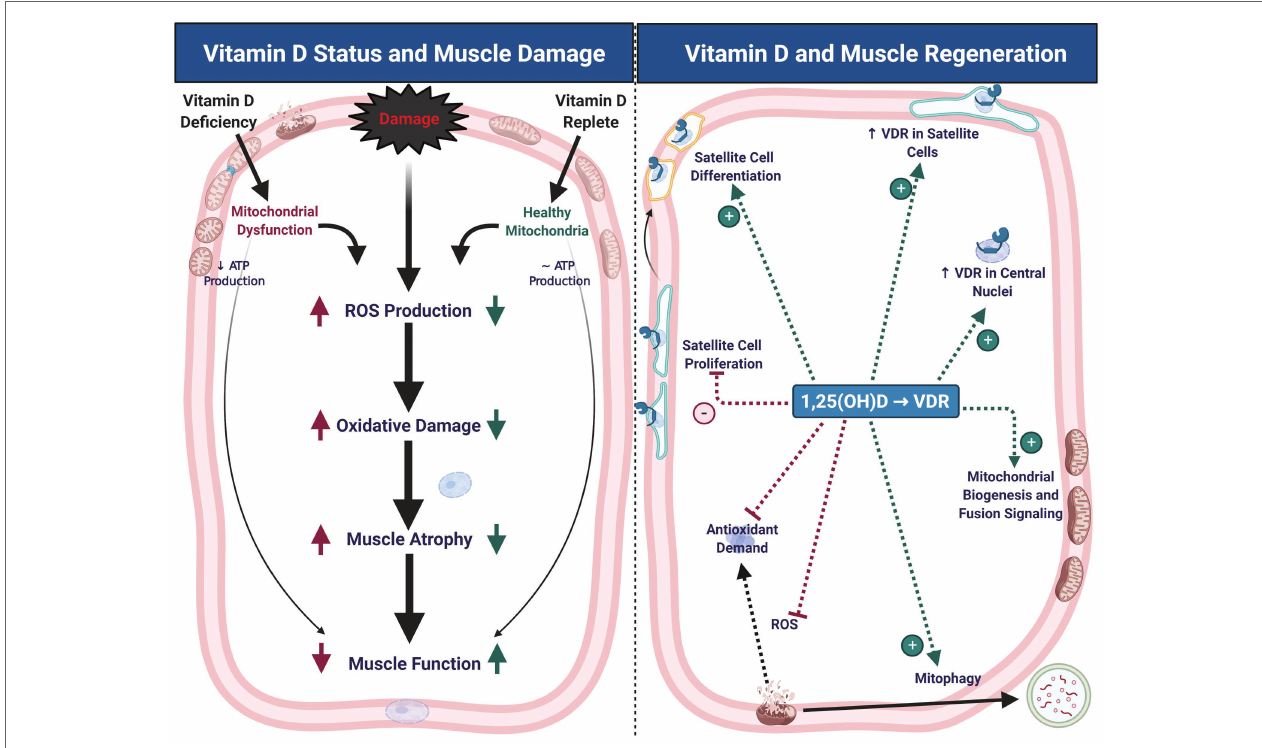
FIGURE 1 | Vitamin D status contributes to muscle damage and regeneration. Vitamin D deficiency leads to mitochondrial dysfunction, decreased adenosine triphosphate (ATP) production, increased reactive oxygen species (ROS) production, oxidative damage, muscle atrophy, and impaired muscle function. These symptoms of deficiency may exacerbate similar symptoms that typically occur with muscle damage (left panel) . During muscle regeneration (right panel) , hydroxylated, activated vitamin D [1,25(OH)D] stimulates an increase in vitamin D receptor (VDR) abundance in satellite cells and central myonuclei. These changes in VDR abundance are accompanied by inhibition of satellite cell proliferation and stimulation of differentiation, which may contribute to maintenance of satellite cell self-renewal capacity. Signaling at the VDR also increases mitochondrial biogenesis and fusion signaling, inhibit ROS production, and thereby mitigate antioxidant demand, which may contribute to a more competent regenerative phenotype. Created with